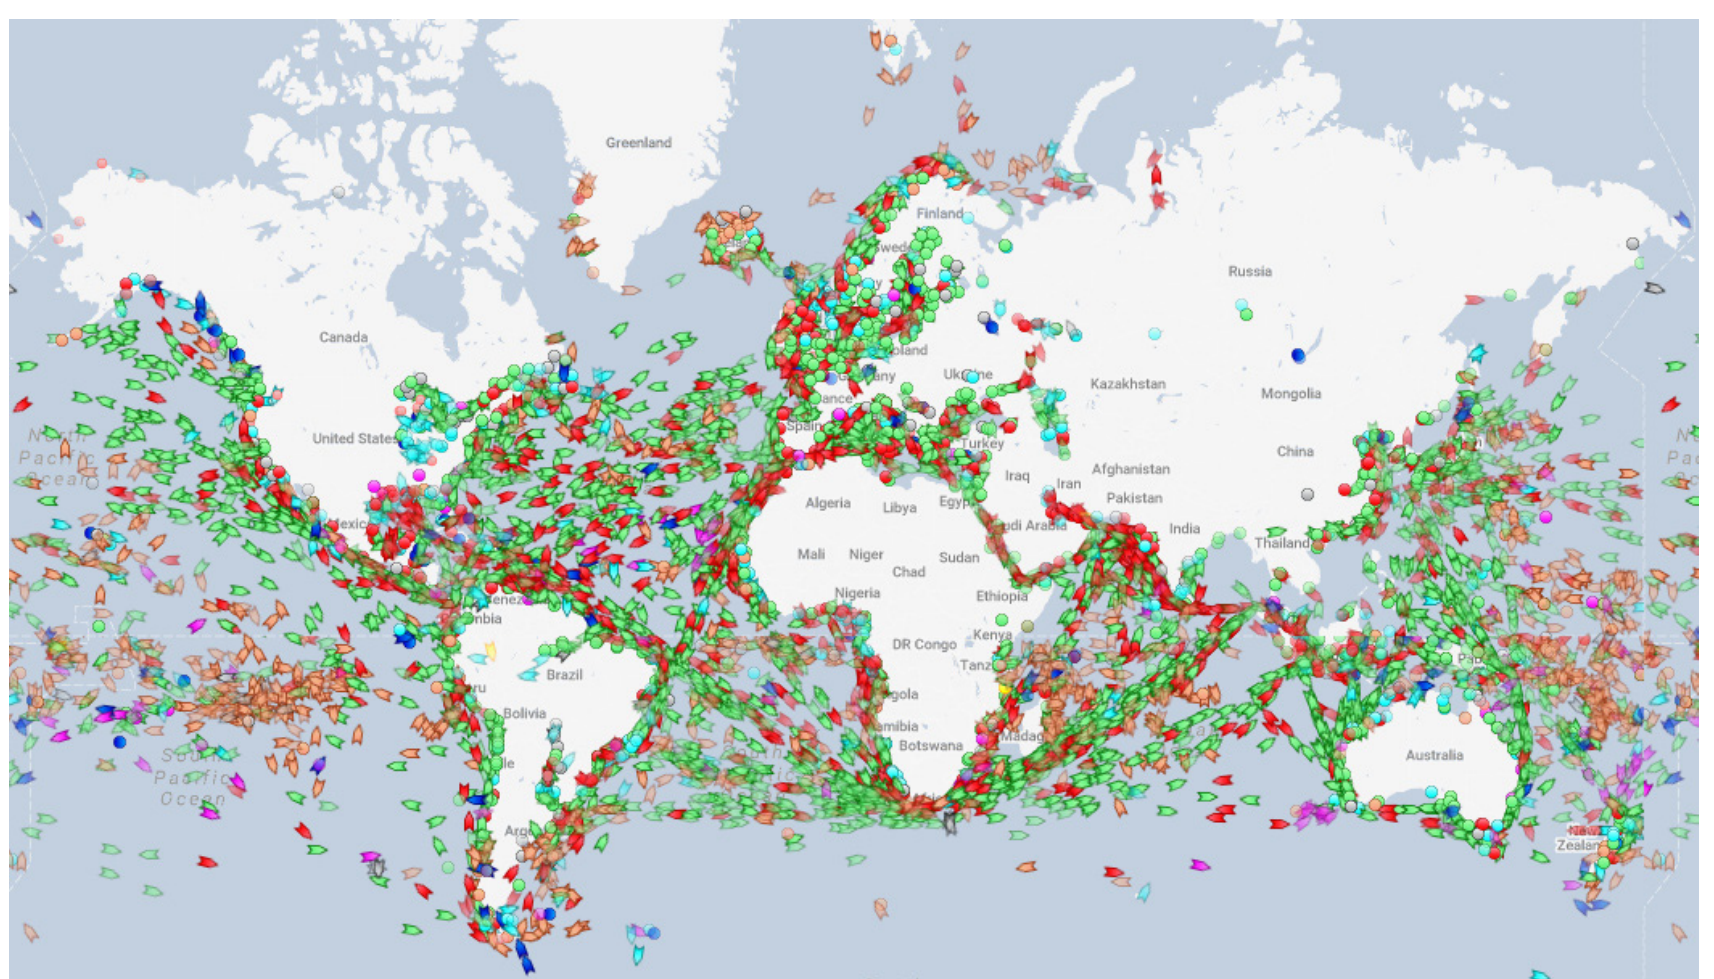
Figure A1. Map of all the ships showing their real-time positions globally at sea, with data obtained through monitoring (MarineTraffic.com, accessed on 23 November 2017).